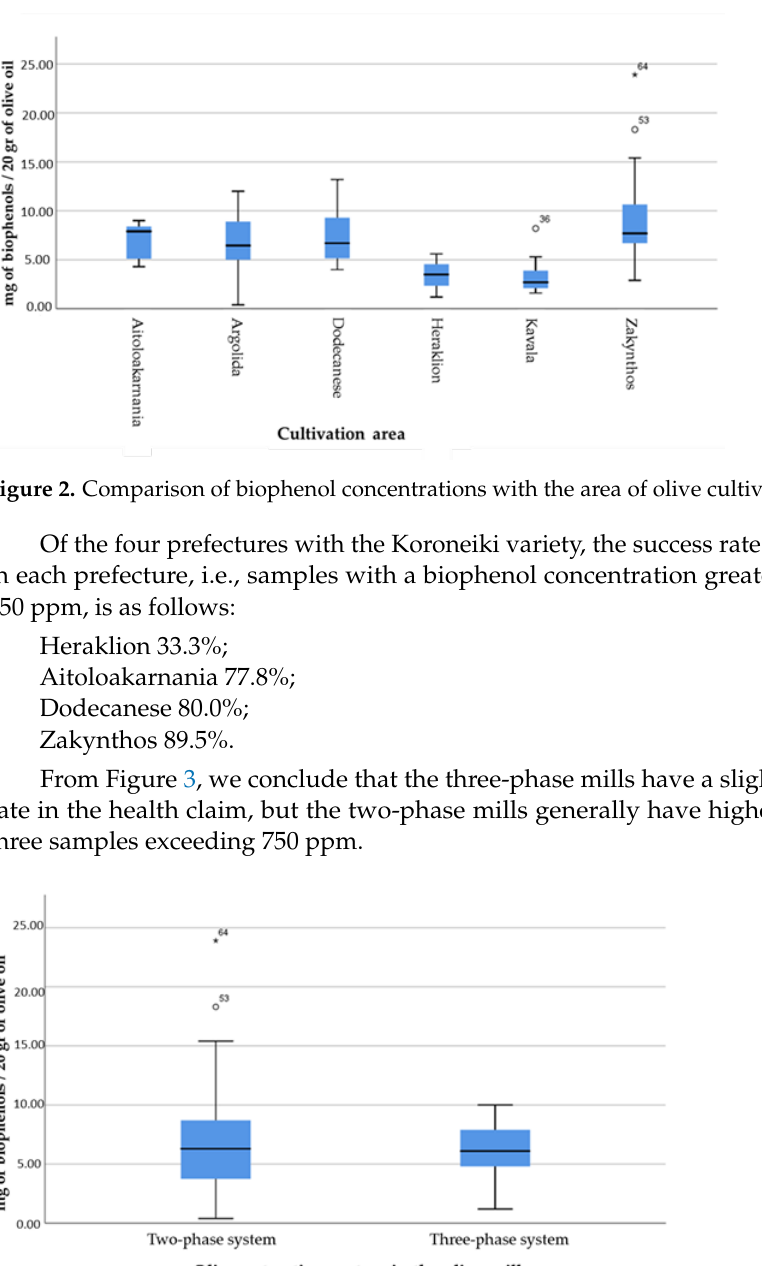
Figure 3. Comparison of biophenol concentrations with the extraction system in the mill.